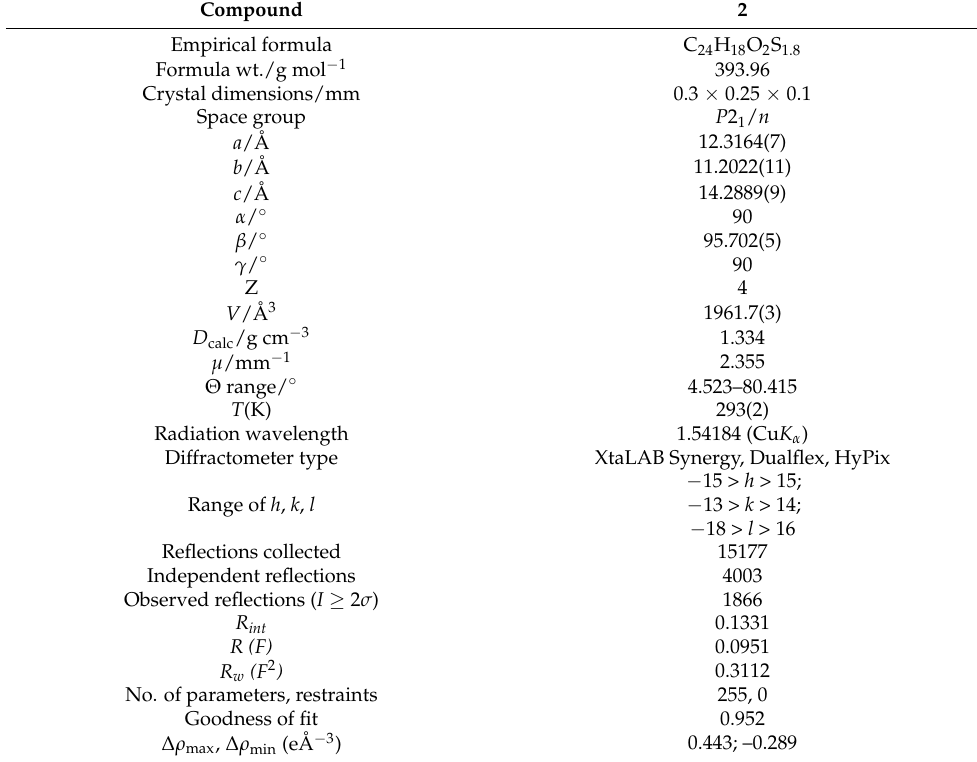
Table 4. Crystallographic data and structure refinement details for dimer 2